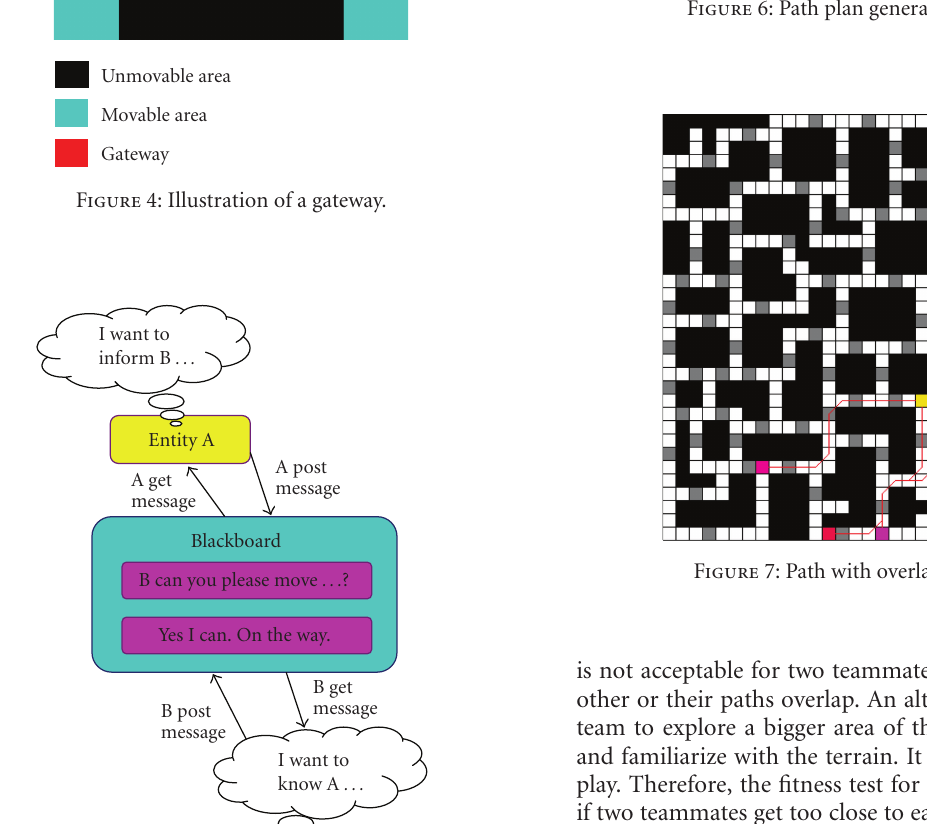
Figure 6: Path plan generation flow chart.